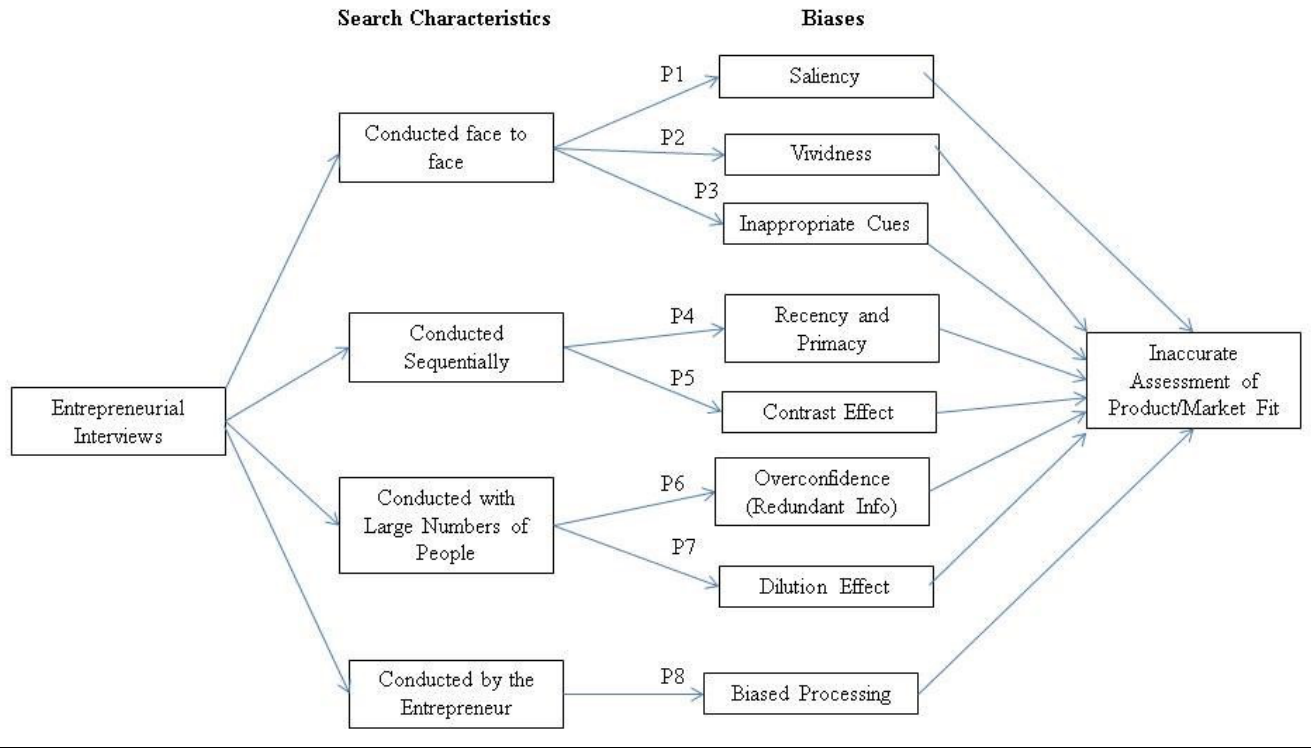
Figure 1. Information Search Characteristics and